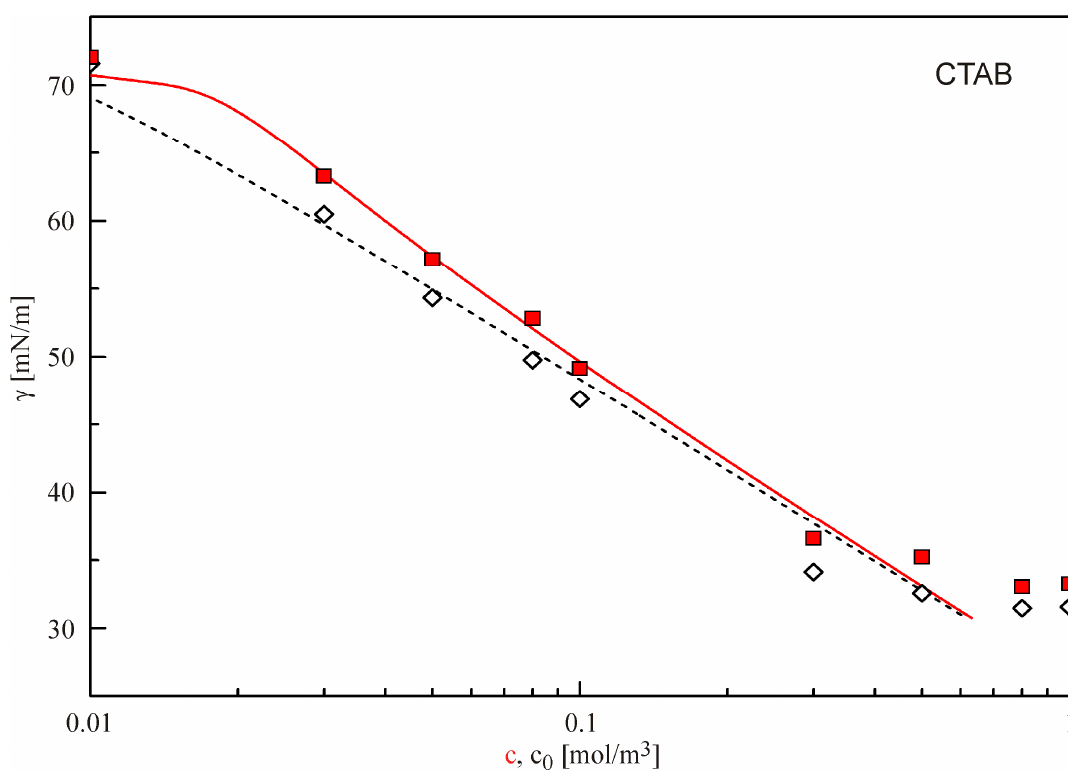
Figure 2. Equilibrium surface tension isotherms for aqueous CTAB solutions, as measured by bubble profile ( ) and drop profile analysis tensiometry ( (cid:4) ); lines represent the fitting results as explained in the text.